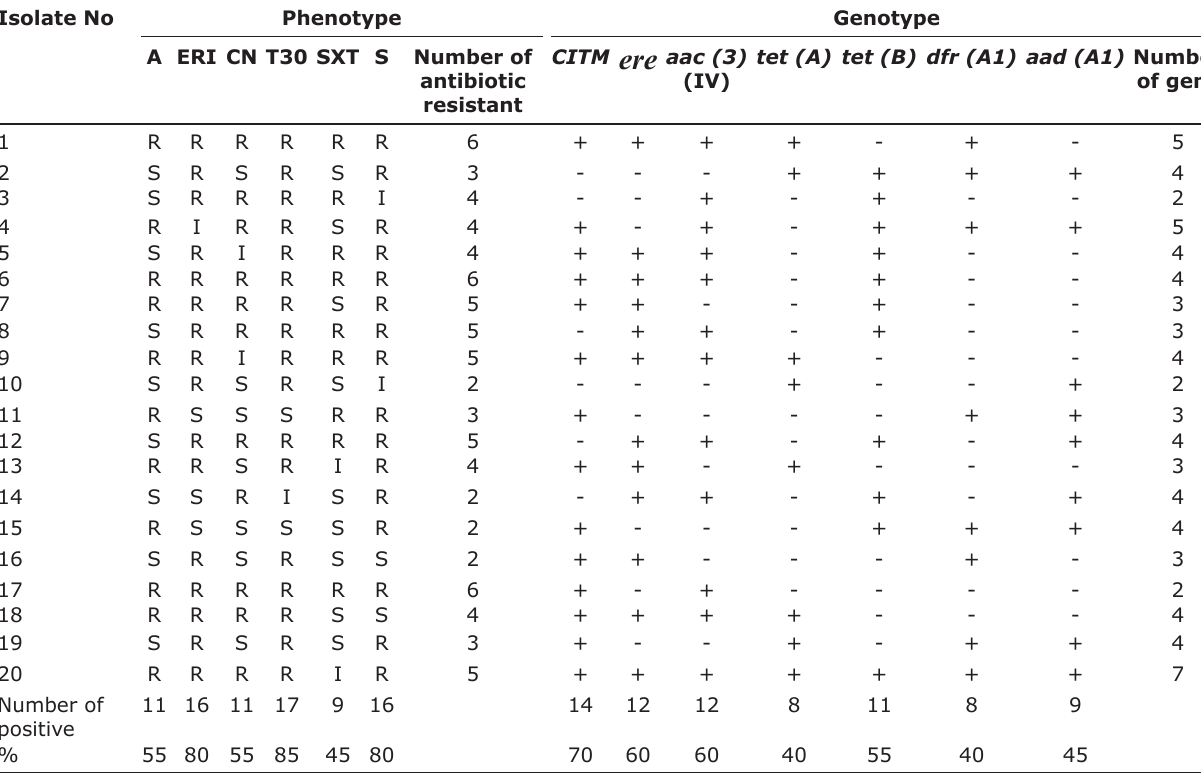
Table-4: Phenotype antibiotic resistance of E. coli in relation to detected genotype. Isolate No Phenotype